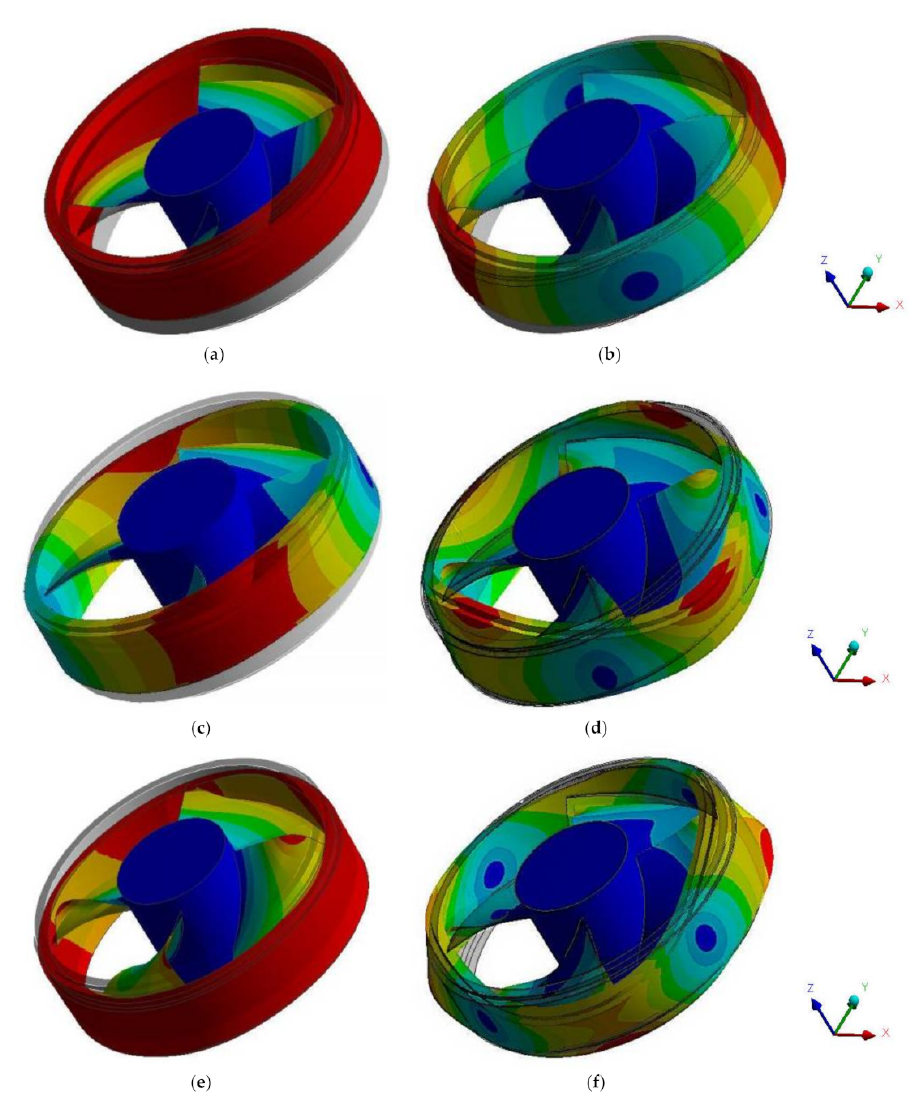
Figure 17. Vibration mode shape in each order modal of the full tubular pump: ( a ) First-order mode, ( b ) Second-order mode, ( c ) Third-order mode, ( d ) Fourth-order mode, ( e ) Fifth-order mode, ( f ) Sixth-order